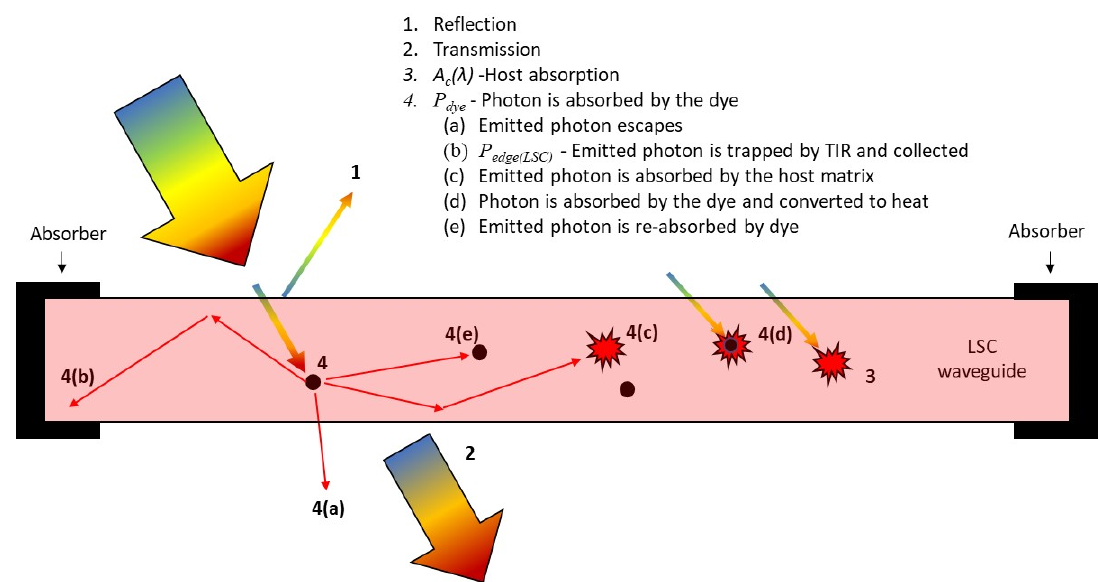
Figure 1. Fate of photons incident onto a luminescent solar concentrator.